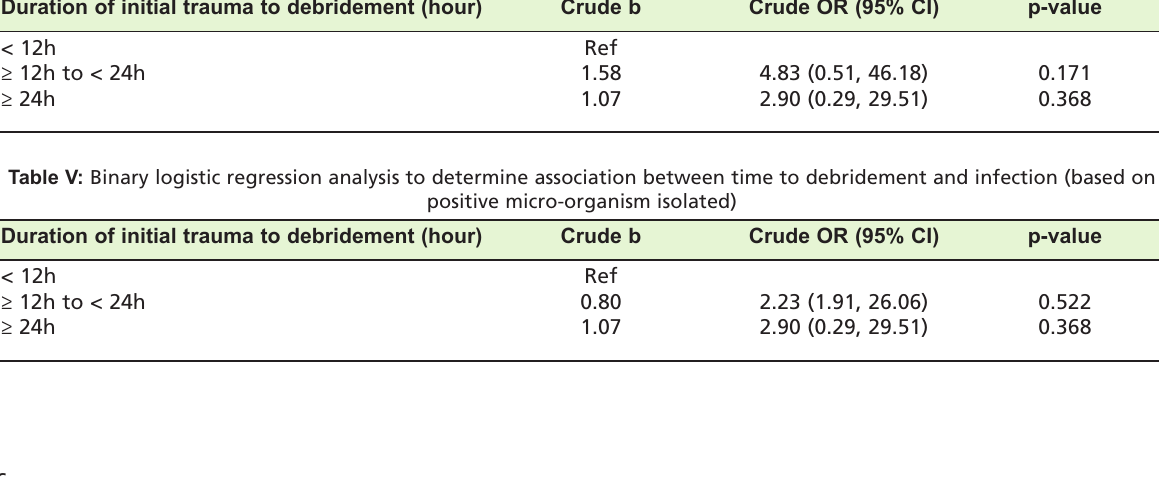
Table IV: Binary logistic regression analysis to determine association between time to debridement and infection (based on wound breakdown, pus and sinus) Duration of initial trauma to debridement (hour)